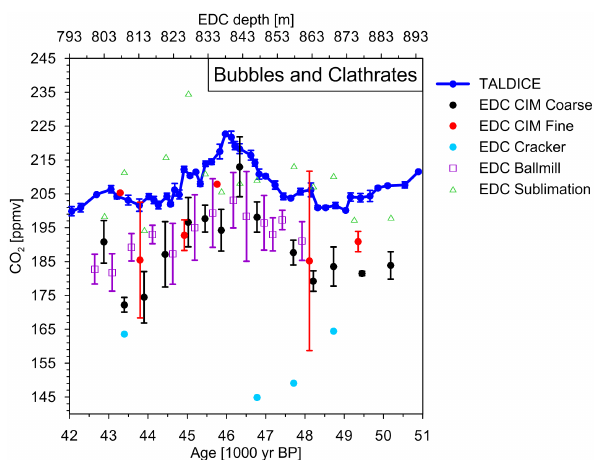
Fig. 7. CO 2 concentrations derived from the BCTZ of the EDC ice core with the CIM system (black and red dots, this study) and our cracker system (light blue dots, L¨uthi et al., 2010) as well as with a system using the sublimation principle of Siegenthaler et al. (2005) (green triangles, L¨uthi et al., 2010) and a ball mill (purple squares, Schaefer et al., 2011) to extract the air. As a reference, data from the fully clathrated ice of the TALDICE core are shown in dark blue (Bereiter et al., 2012) representing the atmospheric concentration. The TALDICE record is synchronised onto the EDML1 Scenario 4 gas age scale (Ruth et al., 2007) according to Bereiter et al. (2012). The EDC records are plotted on EDC3 Scenario 4 gas age scale (Parrenin et al., 2007) which is synchronised to the EDML1 age scale. For 6 CIM data points both the “coarse” (black) and the “fine” (red) CIM settings (see Fig. 3) were applied, whereas the red data points are shifted by 100yr forward in time relative to the corre- sponding black data point for better visibility. The CIM data points with an error bar consist of two to four single measurements and the ones without a bar of only